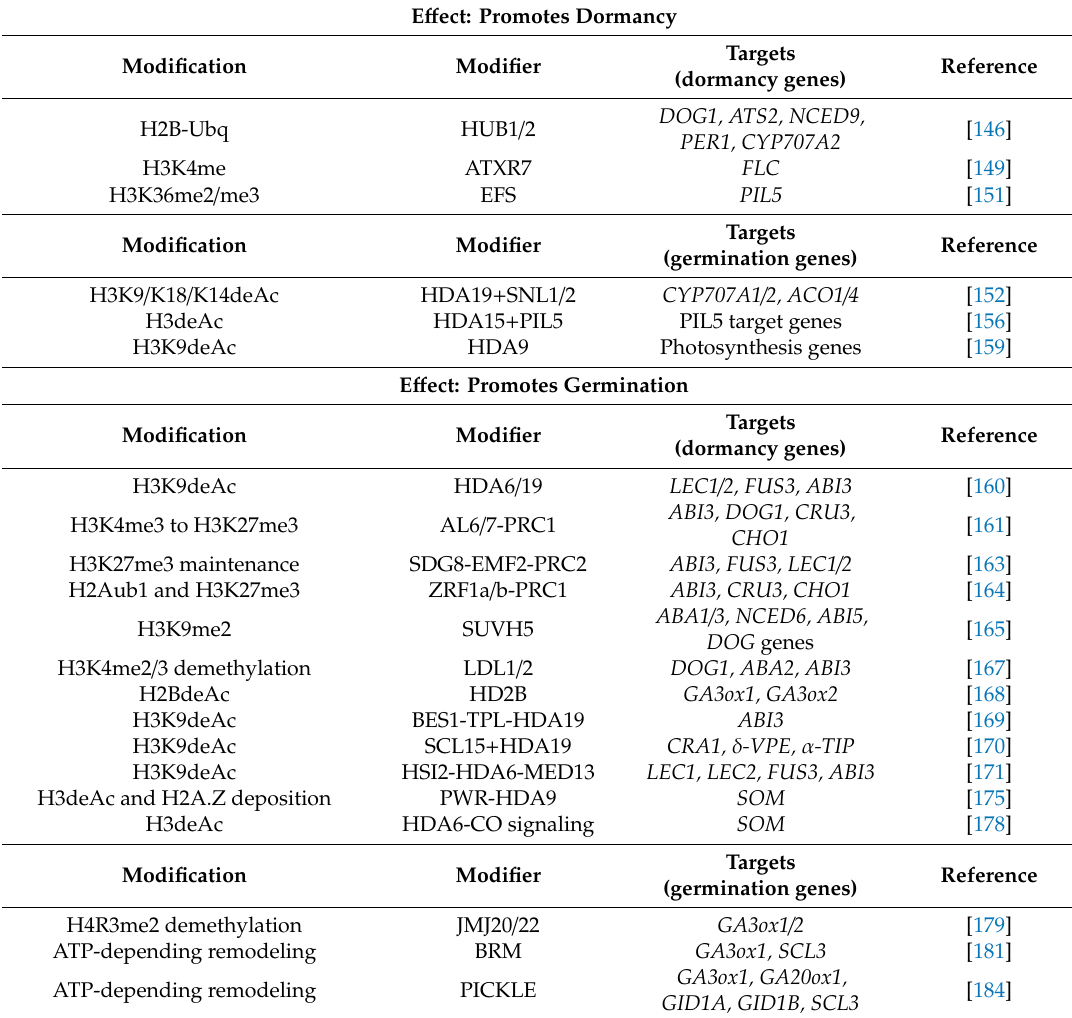
Table 1. Modifiers and remodelers altering the chromatin status of genes promoting dormancy and germination. E ff ect: Promotes